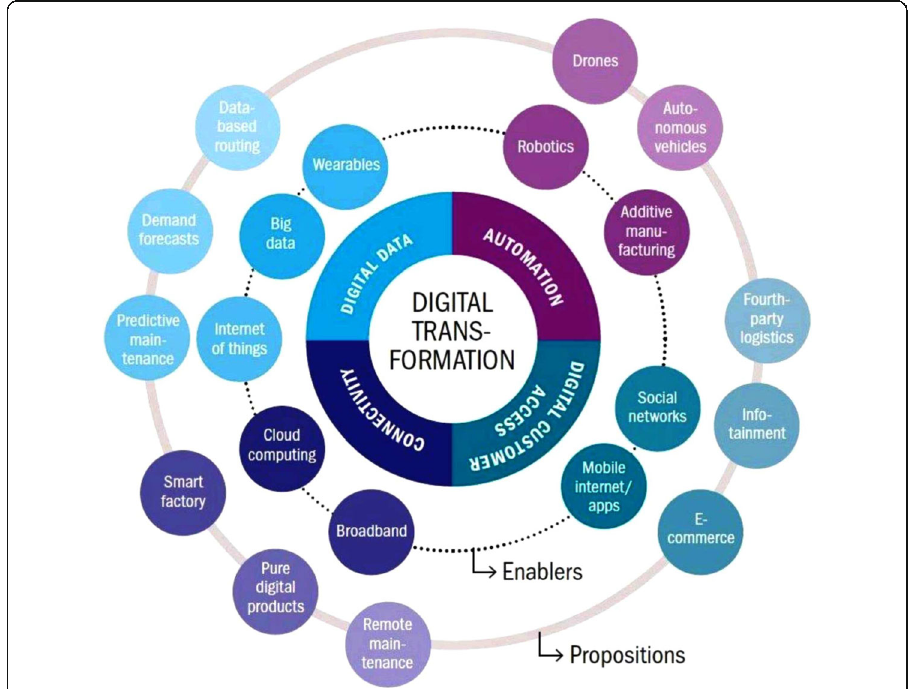
Fig. 6 Digital data transformation (Samsung White Paper,